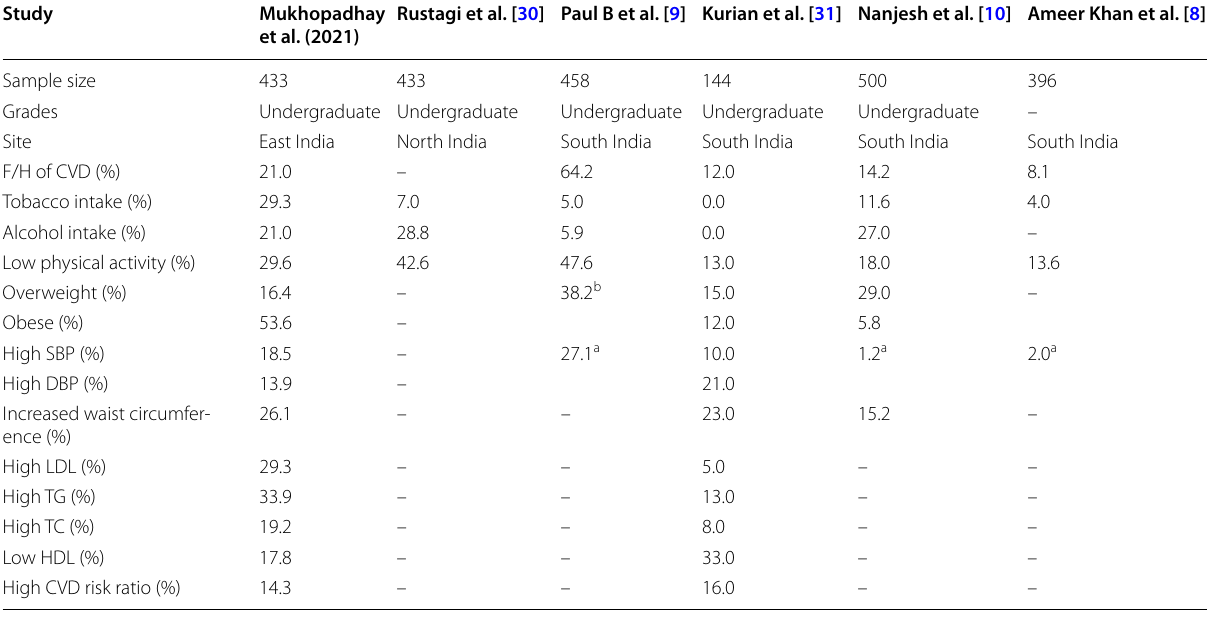
DBP, diastolic blood pressure; CVD, cardiovascular disease; HDL, high density lipoprotein; LDL, low density lipoprotein; SBP, systolic blood pressure; TC, total cholesterol; TG,